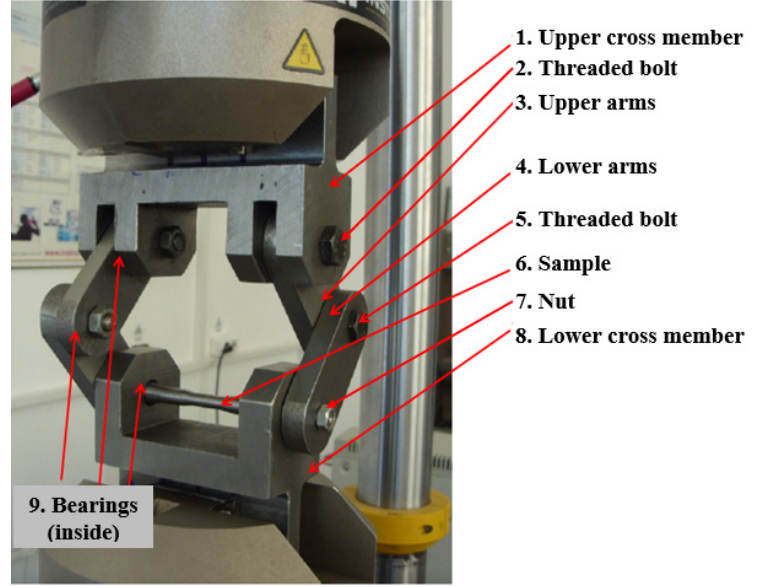
Figure 1. Torsion fatigue device—fixed in the pulsating testing machine.